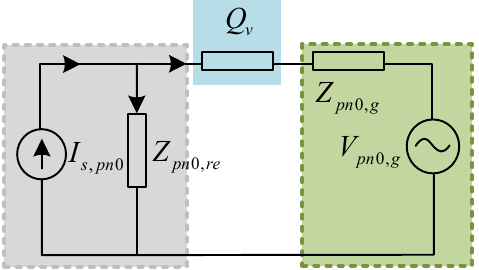
Figure 11. Equivalent model of interactive system between LCL-TFSCI and grid after impedance reshaping.